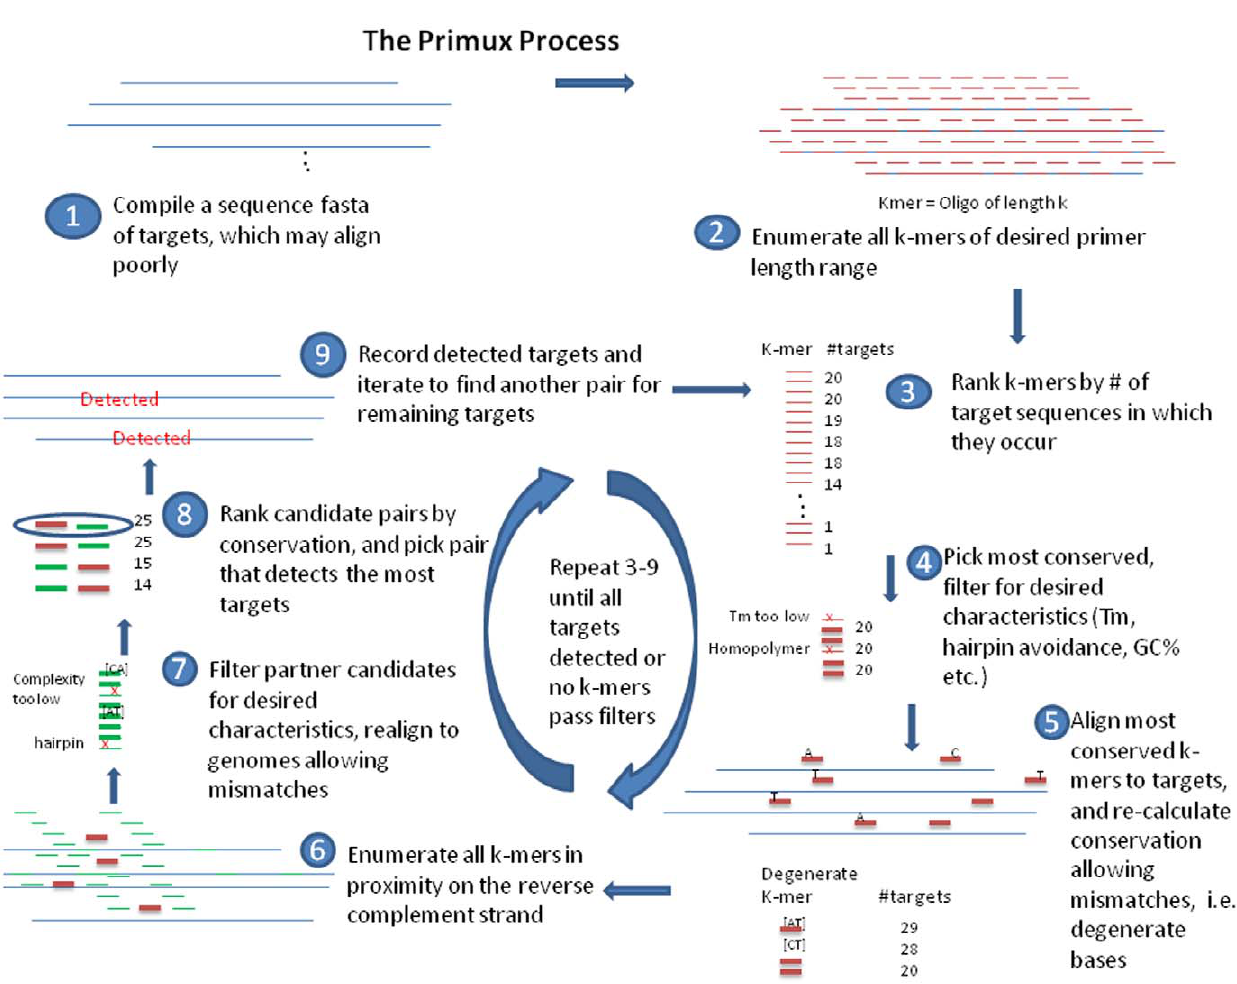
Figure 2. Diagram of the PriMux approach.